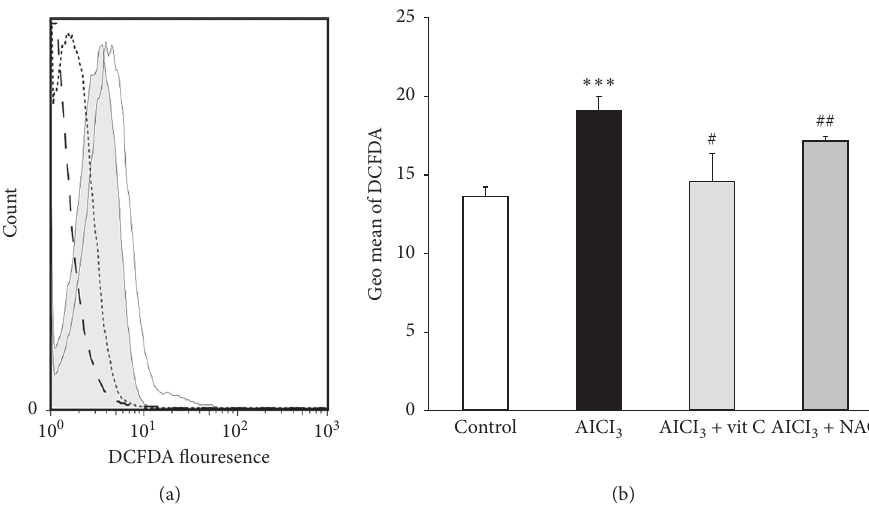
Figure 6: The effects of AlCl 3 on the formation of reactive oxygen species. (a) Original histogram of DCFDA fluorescence in erythrocytes following exposure for 24hours to Ringer solution (control, grey areas), AlCl 3 (100 µ M, black lines) AlCl 3 (100 µ M) in the presence of vit C (0.6mM, dotted lines) and NAC (1mM, dashed lines). (b) Geo means ± SD of DCFDA fluorescence in erythrocytes after a 24hours’ treatment with AlCl 3 (100 µ M) in the presence of vit C (AlCl 3 +vit C) and NAC (AlCl 3 + NAC). ∗∗∗ P < 0.001 compared to the control group, # P < 0.01 compared to the AlCl ## P < 0.05 compared to the AlCl 3 group, and 3 group.